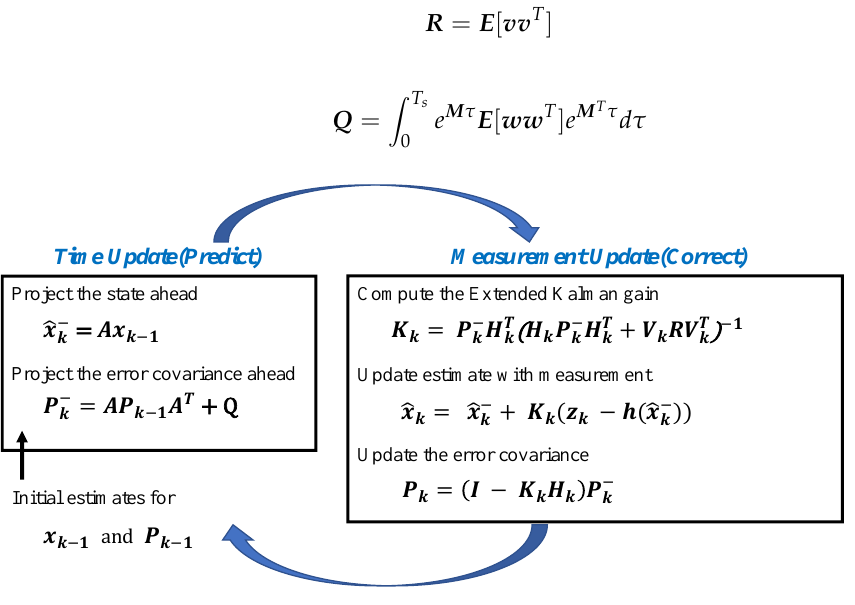
Figure 7. Extend Kalman filter